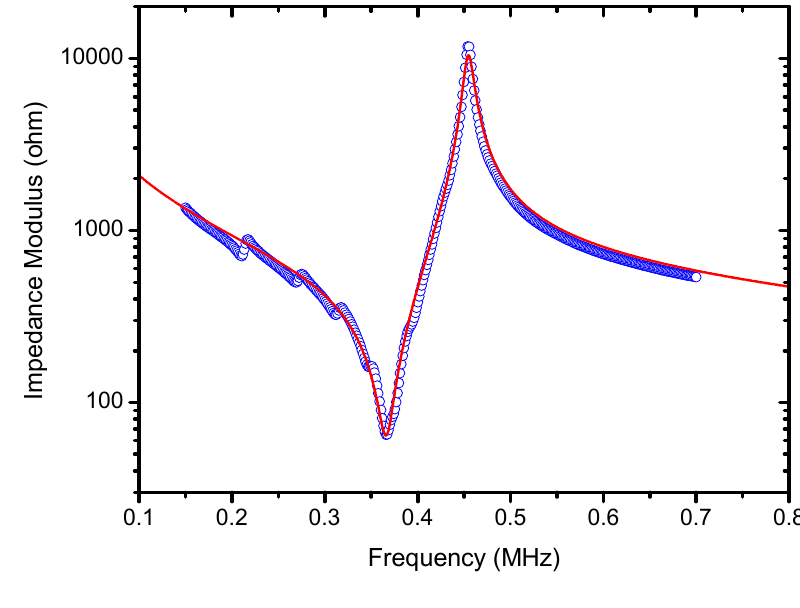
Figure 8. Modulus of the electrical impedance of the piezocomposite disk vs frequency. Circles: experimental measurements, solid red line: theoretical calculation.